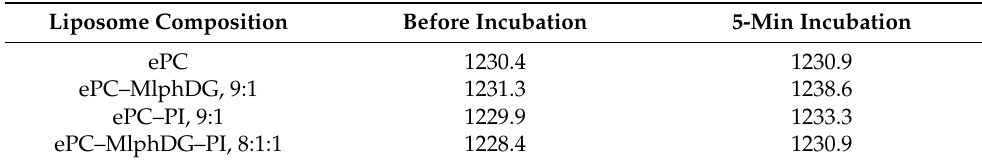
Table 3. Changes in frequencies (cm − 1 ) of asymmetric stretching vibrations of phosphate groups upon incubations of different liposome samples with serum albumin.